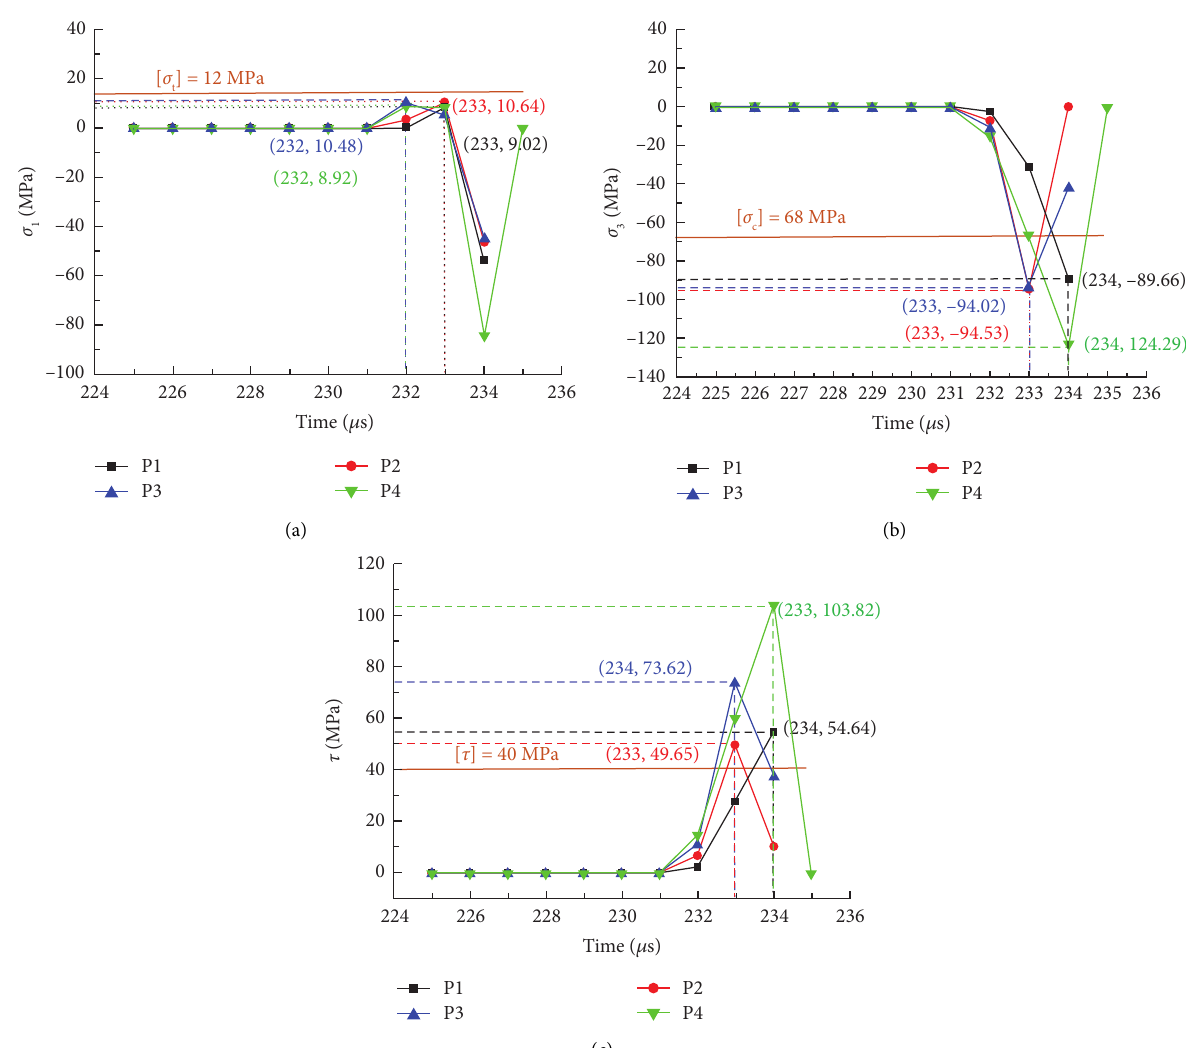
Figure 7: Stress variation curves of four particles in the liquid–solid contact area versus time.